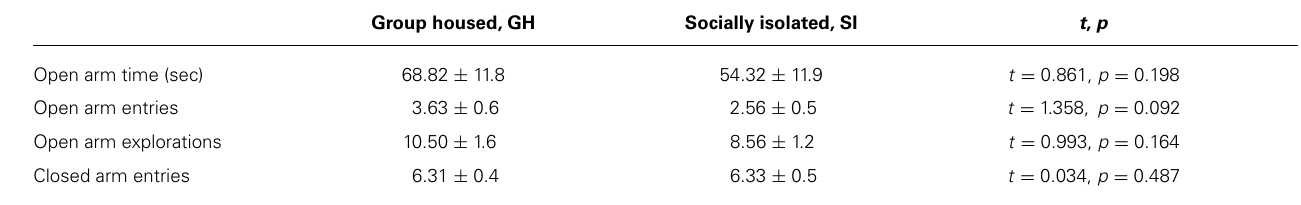
Table 1 | Group housed (GH) and socially isolated (SI) rats were tested for anxiety-like behaviors on the elevated plus maze after the 6 week housing period. Group housed,